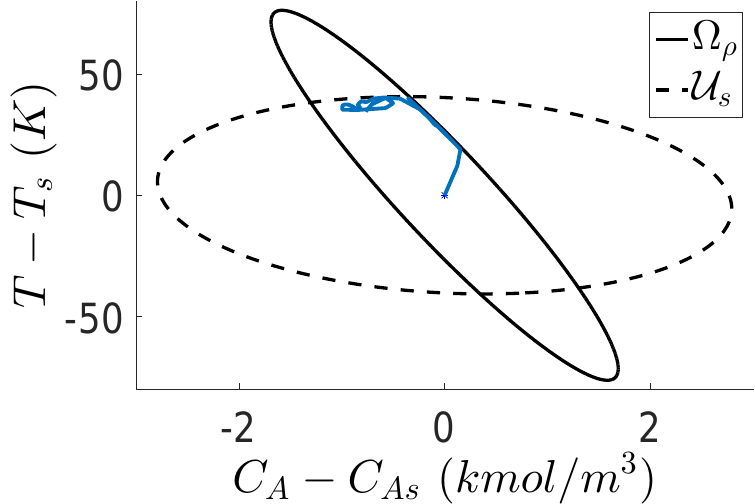
(cid:82) t s u 1 ( τ ) d τ = t s 0